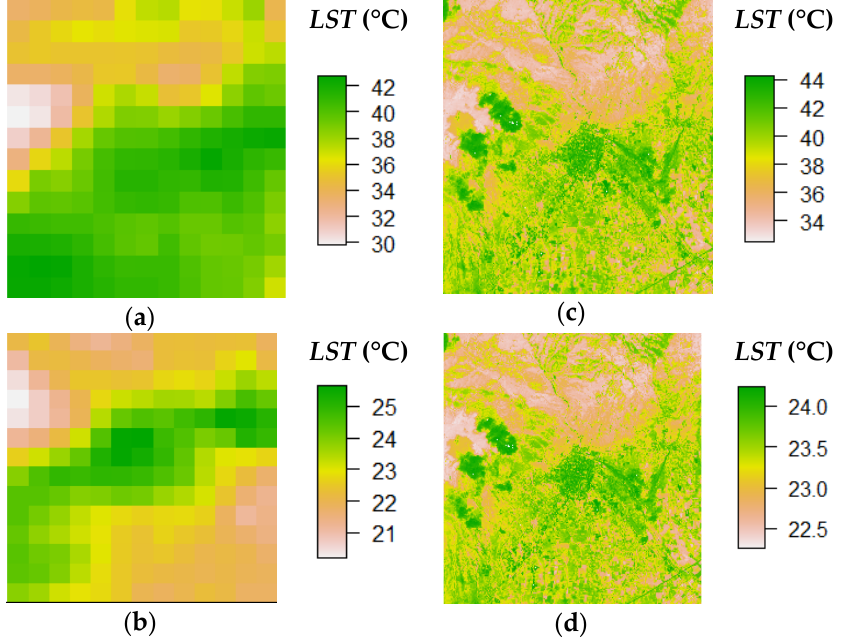
Figure 6. ( a ) The MODIS LST image (1000 m) on 30 July 2016 (11:35 UTC + 3). ( b ) The LST image (1000 m) on 30 July 2016 (22:28 UTC + 3). ( c ) The downscaled image (10 m) on 30 July 2016 (11:35 UTC + 3). (d) Downscaled image (10 m) on 30 July 2016 (22:28 UTC + 3). Table 8. The LST values in both city and suburbs at 1000 m and 10 m spatial resolution.